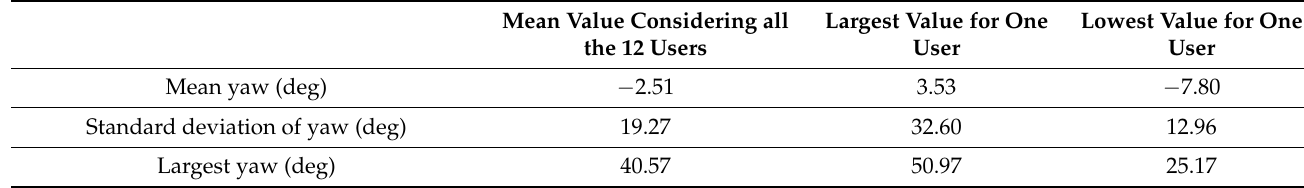
Table 2. Statistics about yaw and pitch obtained from Oculus